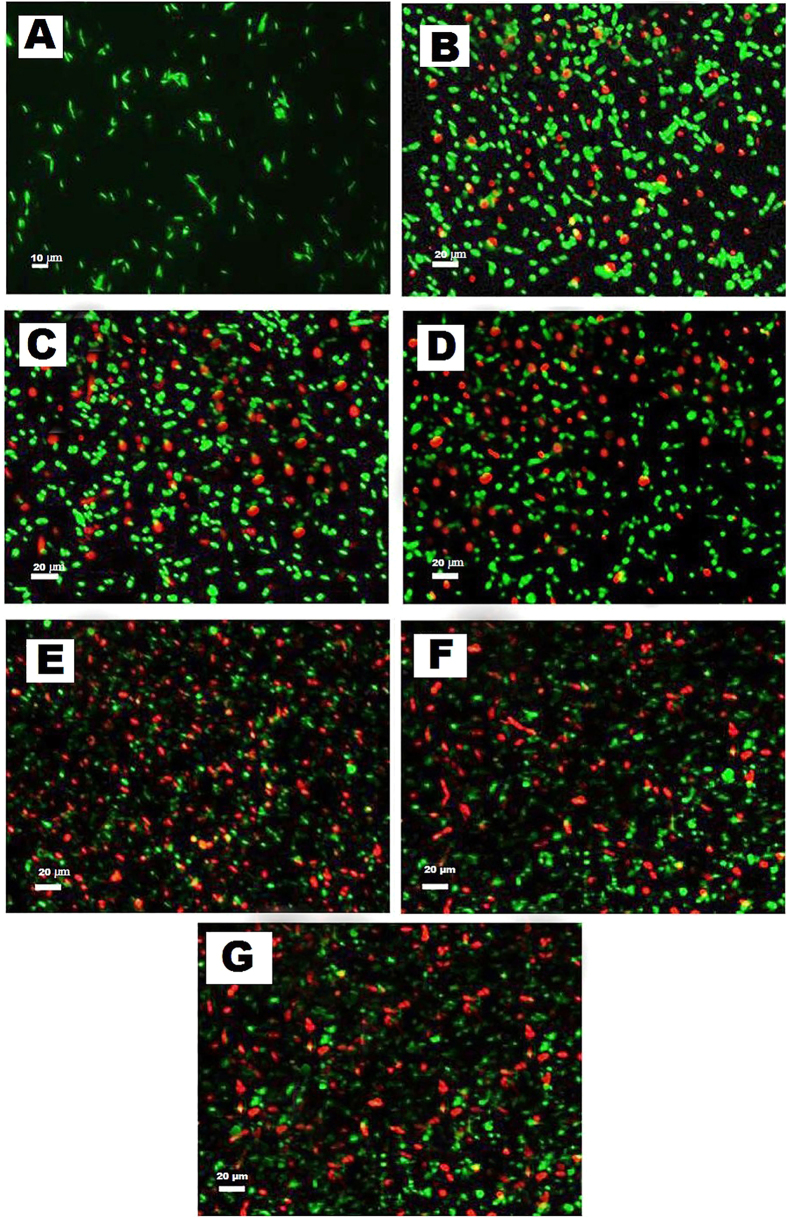
Results of LIVE/DEAD BacLight bacterial viability visualized in the fluorescence microscopy.P. aeruginosa cells treated with control (A) SNP alone (B) SNP + CEF (C) SNP + MUP (D) SNP + GEN (E) SNP + TET (F) and SNP + VAN. Cells with a damaged membrane showing red color fluorescence where as cells with an intact membrane showing green color fluorescence.